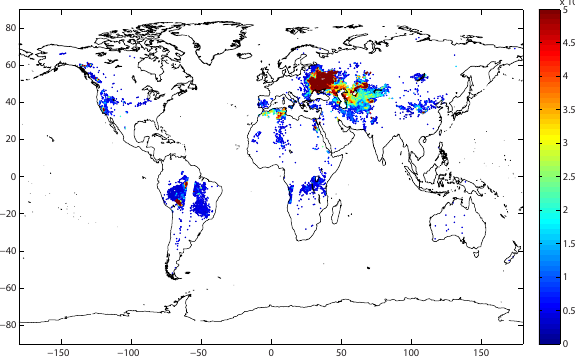
Fig. 2. IASI morning NH 3 observations (moleccm − 2 ) on 15 Au- gust 2010 obtained using the FORLI processing chain. The high concentrations measured in eastern Europe are due to the excep- tional emissions from the large Russian fires in the summer of 2010 (R’Honi et al.,